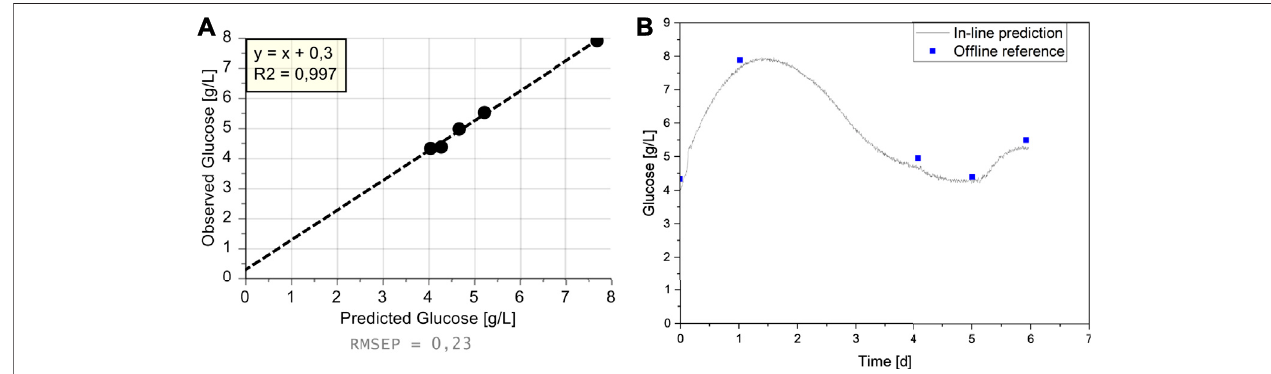
FIGURE6| ProcessdataoftheN-stageperfusionC7within-lineglucosecontrol.TheVCDandviability (A) aswellasglucosein-lineandoff-linemeasurements (B) are shown. VCD, viability, and off-line glucose concentration were not measured after day 14.